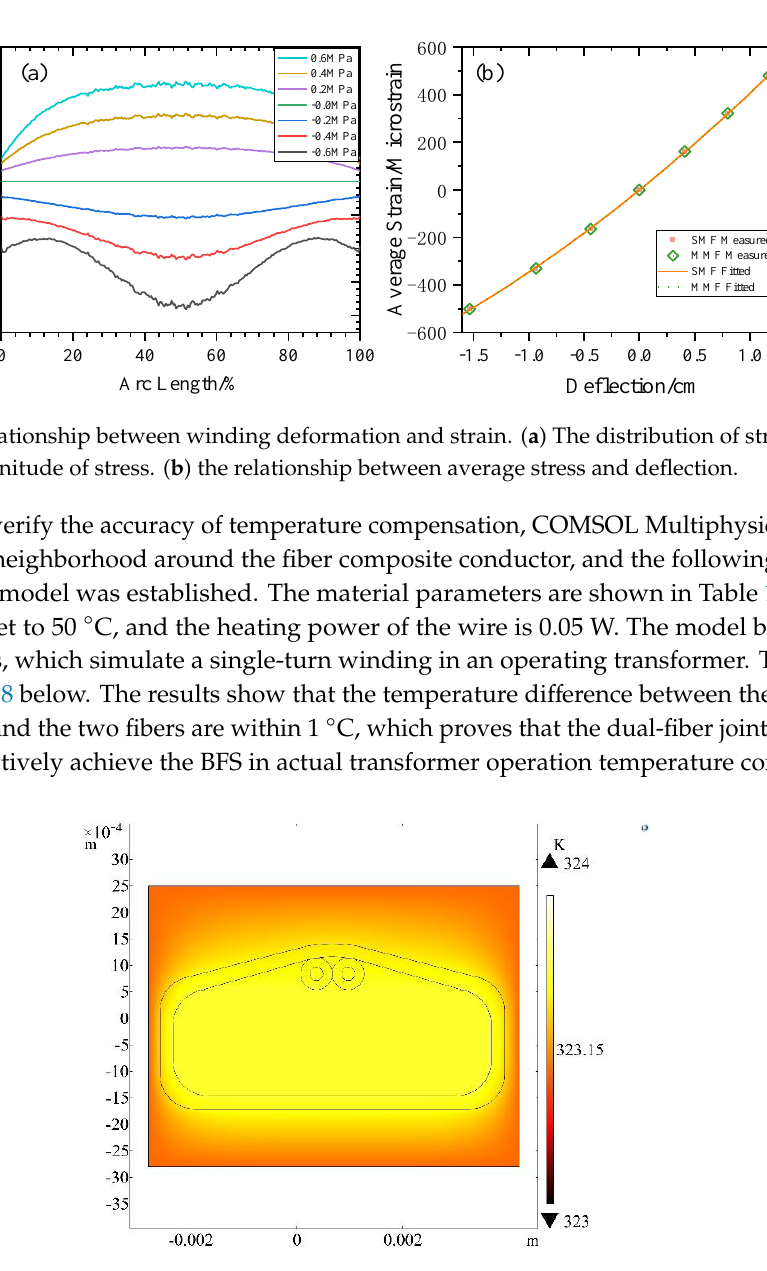
Figure 8. Winding temperature field distribution.